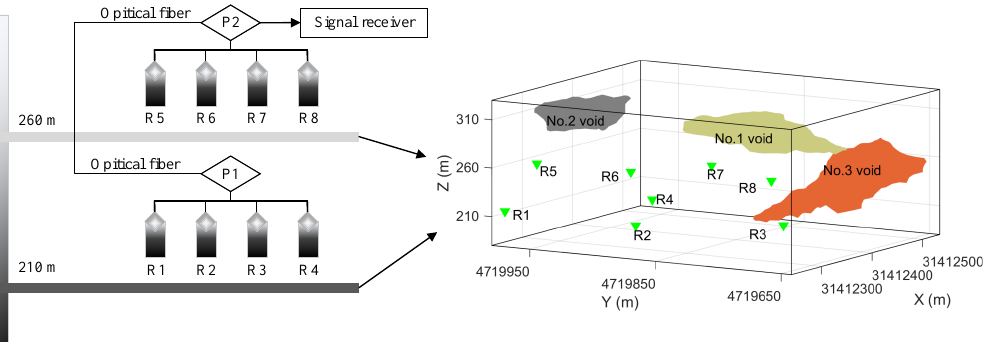
Figure 14. Distributions of voids and sensors in the Huangtupo Copper and Zinc Mine. P1, P2 are collection devices.